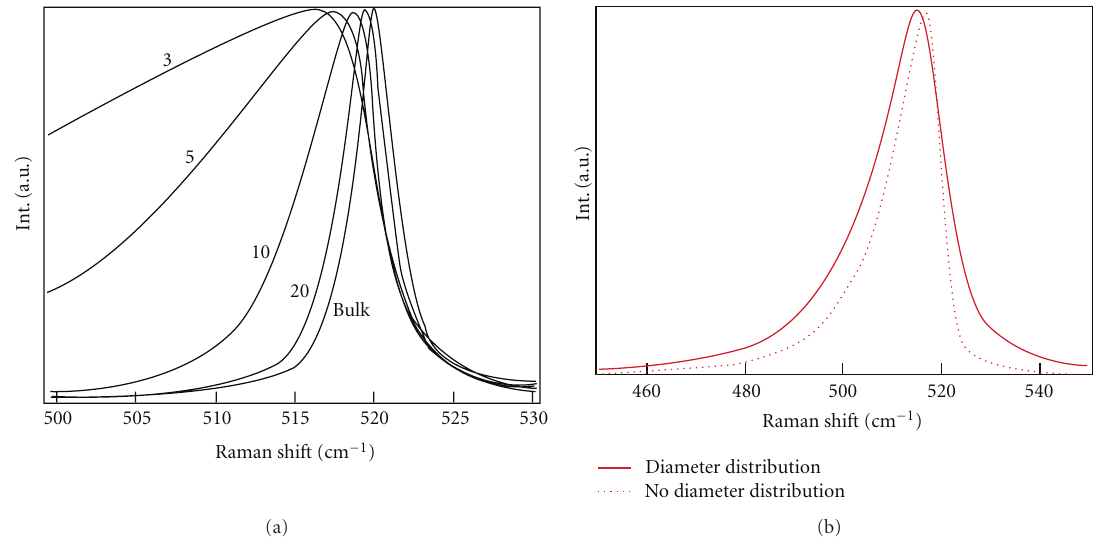
Figure 6: (a) A plot showing the finite-size-induced phonon confinement e ff ect (downshift and asymmetric broadening to lower energy) for di ff erent diameters of Si nanowires and the Lorentzian line shape of the bulk, for comparison. (b) Comparison of the Raman line shape of 8nm diameter Si nanowires, taking diameter distribution into account and without diameter distribution. The peak downshift ∼ 1 cm − 1 and the line width broadened ∼